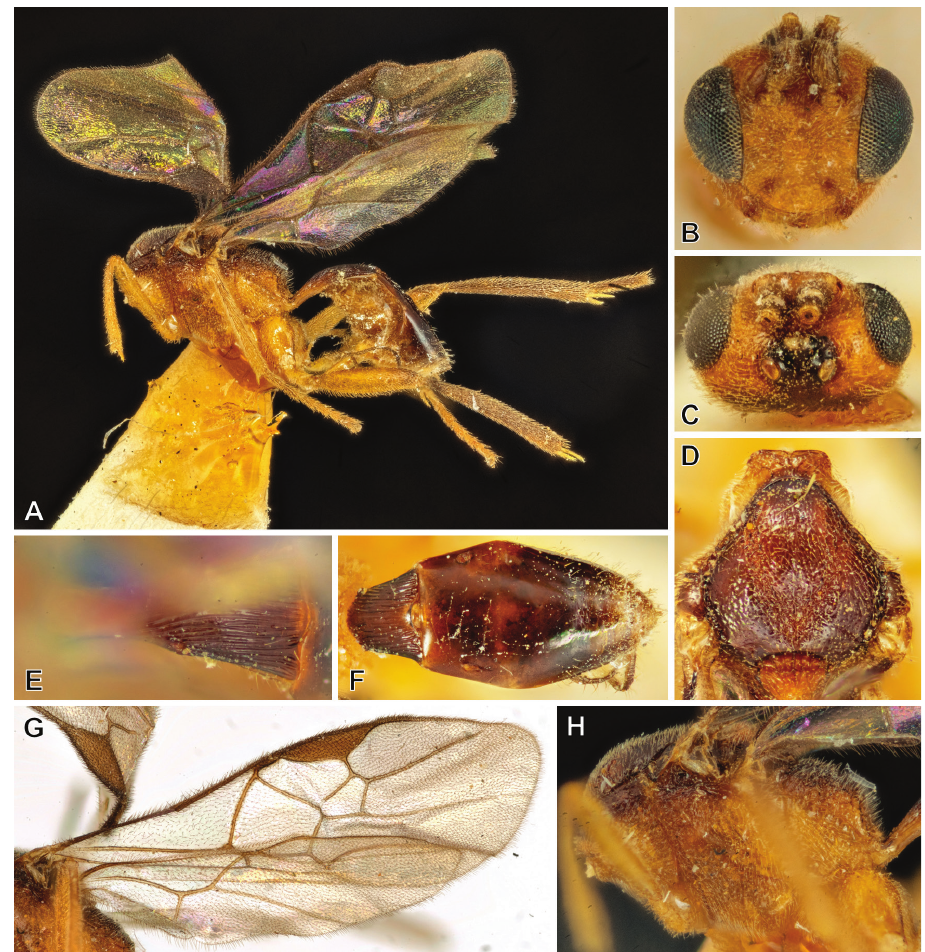
Figure 4. Meteorus komensis Wilkinson, ♀ holotype A habitus B head, frontal view C head, dorsal view D mesoscutum, dorso-lateral view E T1, dorsal view F T2 and following tergites, dorsal view G forewing H mesosoma, lateral